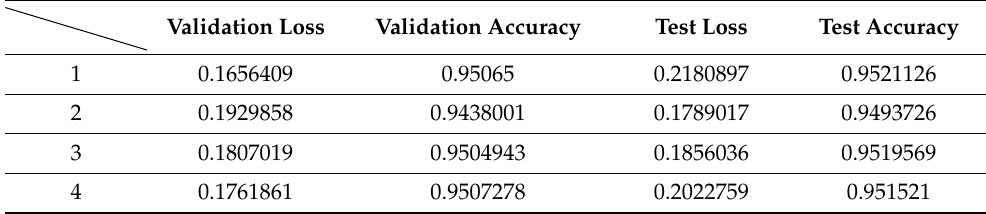
Table 4. The prediction performance of DNN-based DTI model by 10-fold